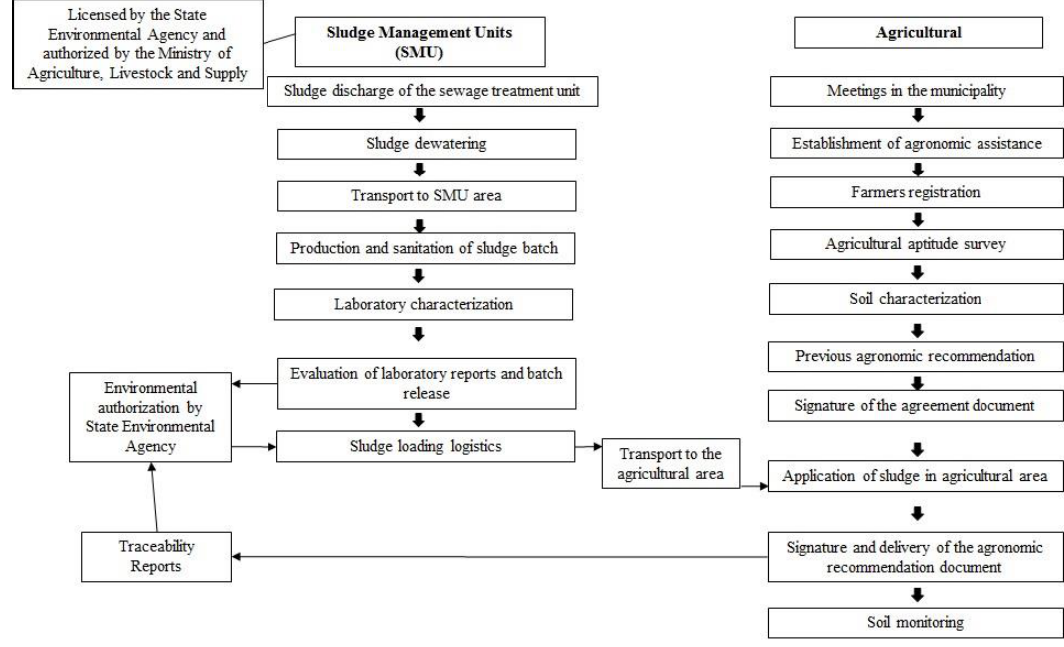
Figure 2. Flowchart of the management process of sewage sludge agricultural use in Paraná.